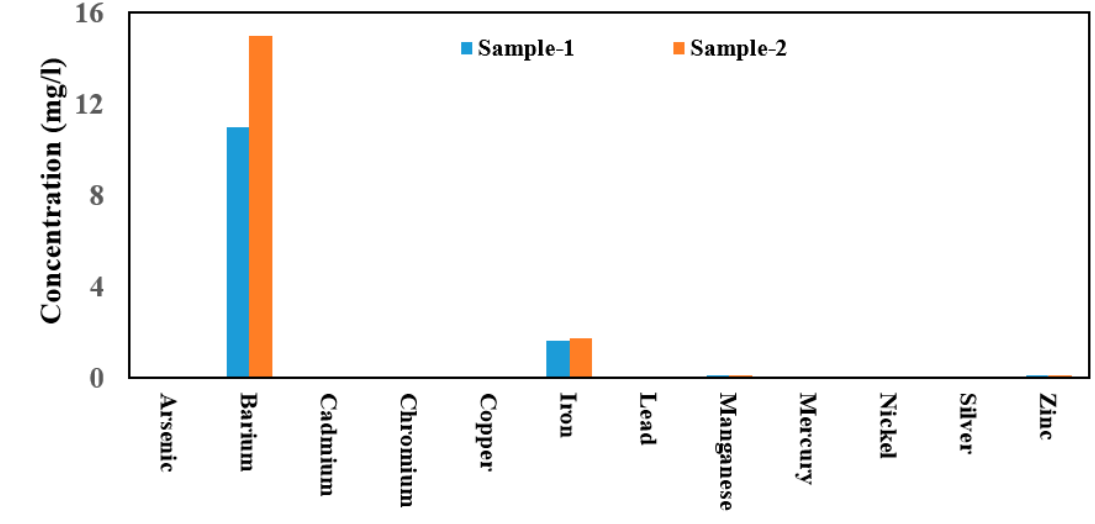
Figure 4. Concentration (mg/L) of metal ions in wastewater samples-1 and -2. Table 3. Concentration of nonmetals and metals in industrial wastewater samples collected from the study area.